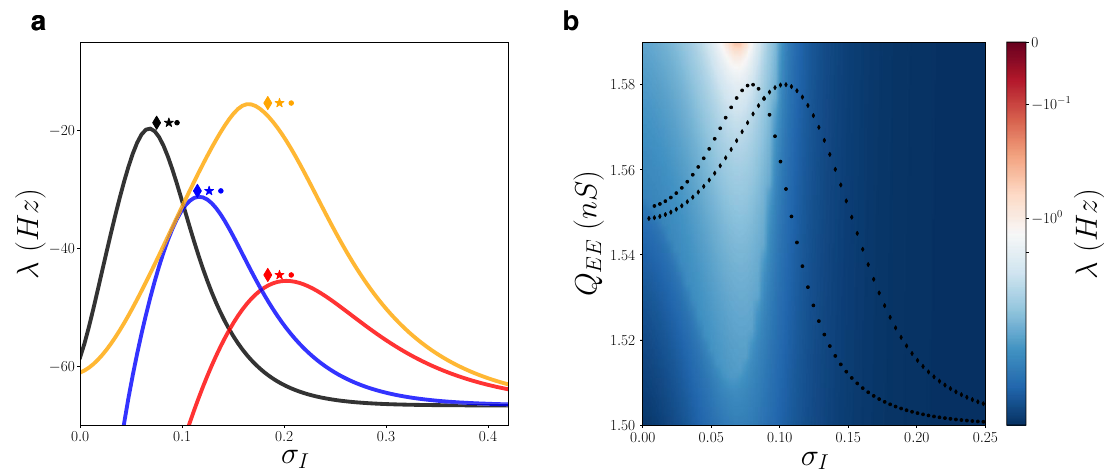
Figure 3. Enhanced responsiveness corresponds to regions closer to instability. ( a ) The largest stability Lyapunov exponent (cid:31) (real part) of asynchronous dynamics as a function of the heterogeneity of inhibitory neurons ( σ I ). Different colors indicate different parameters of the baseline external drive and the strength of excitatory-excitatory quantal conductance ( ν 0 , Q EE ), i.e. black (1.5 Hz, 1.5 nS), red (3 Hz, 1.5 nS), blue (2 Hz, 1.5 nS) and orange (3 Hz, 1.65 nS). Symbols are located at the value of σ I for which the responsiveness R is maximum (same color code as continuous line). Different symbols indicate different amplitudes A of the input, diamond ( A = 0.1 Hz), star ( A = 0.5 Hz) and dot ( A = 1 Hz). ( b ) The larger stability Lyapunov exponent (cid:31) of asynchronous dynamics as a function of the heterogeneity of inhibitory neurons ( σ I ) and the strength of excitatory-excitatory quantal conductance Q EE for a baseline external drive ν 0 = 1.5 Hz. The dotted (diamond) line is the responsiveness R for an input amplitude A = 0.1 Hz ( A = 1 Hz ) and Q EE = 1.5 nS (as in Figs. 1